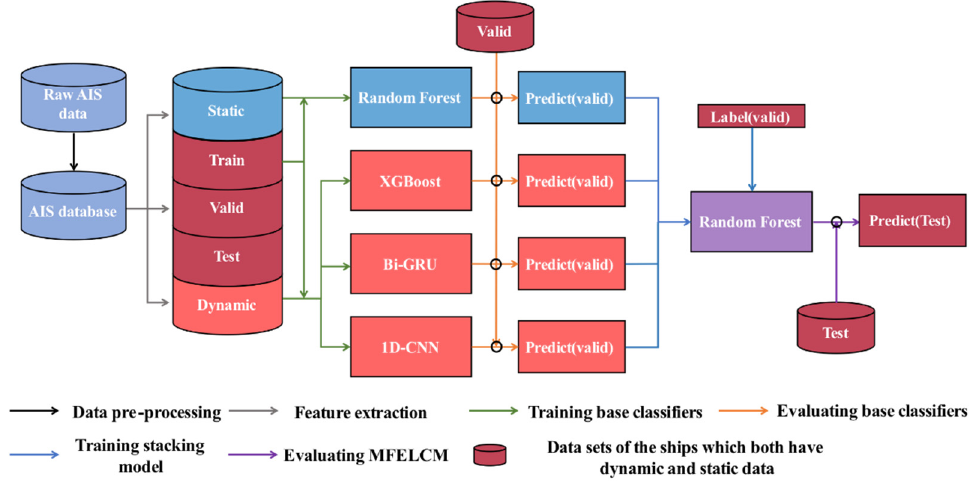
Figure 2. The overall process of MFELCM.